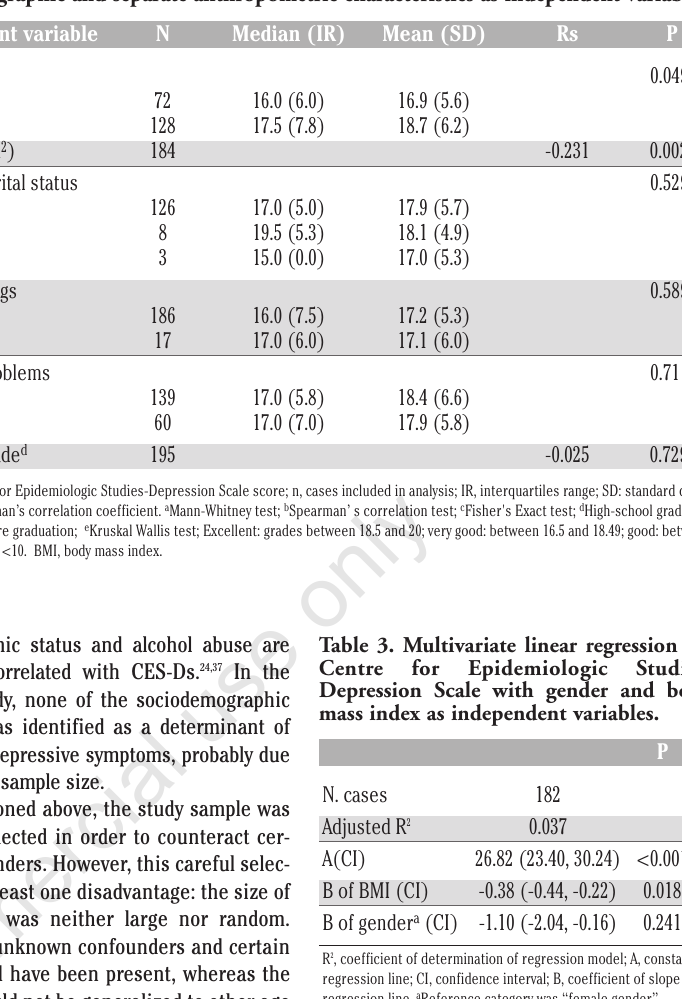
Table 2. Univariate analysis for Centre for Epidemiologic Studies-Depression Scale with sociodemographic and separate anthropometric characteristics as independent variables.